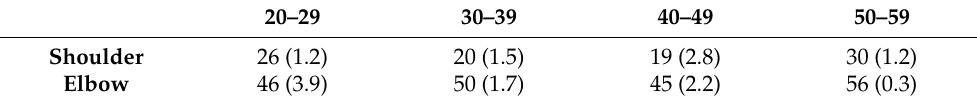
Table 4. Difference of maximum and minimum values of joint angles during lifting phase.